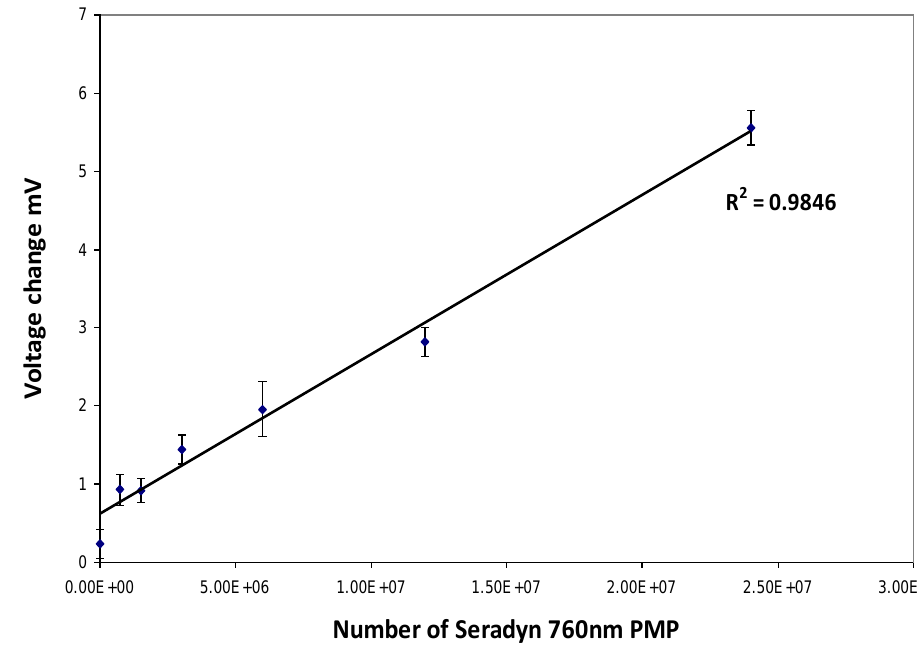
Figure 3. Relationship of number of Seradyn 760 nm paramagnetic particles (PMPs) and response in the RCM Slope = 2.044 × 10 −7